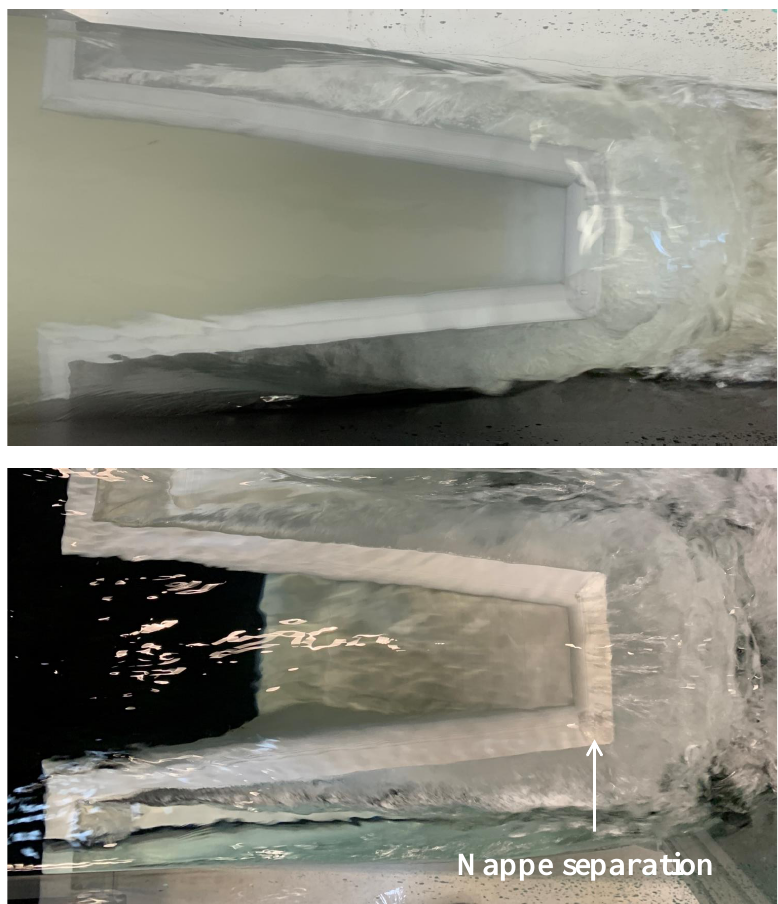
Figure 8. Comparison of nappe trajectory for trapezoidal piano key weir model at H T P − 1 = 0.34, top : TPKW P30 , bottom : TPKW P40